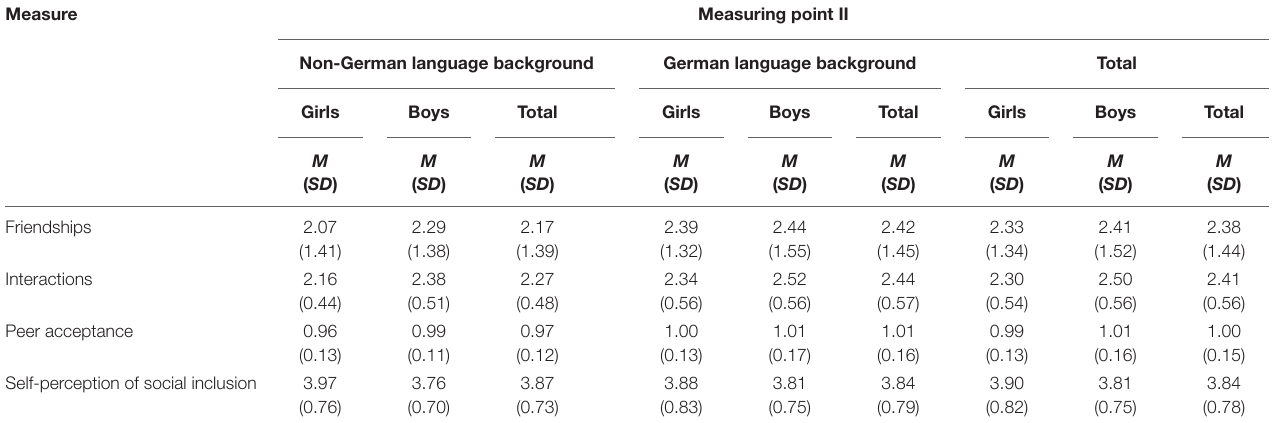
TABLE 10 | Mean values and standard deviations of the dimensions of social participation at measurement point